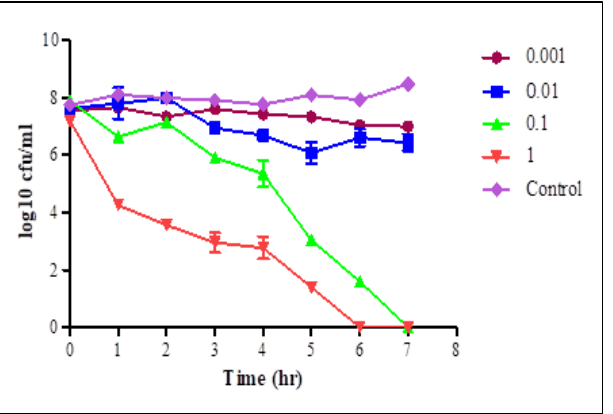
Figure 4. Lytic activity of STEC P4 after infection of STEC O157:H7 wild type strain 93111 at MOI of 1, 0.1, 0.01 and 0.001 for 7 h. LSD value at 0.05: 0.523.